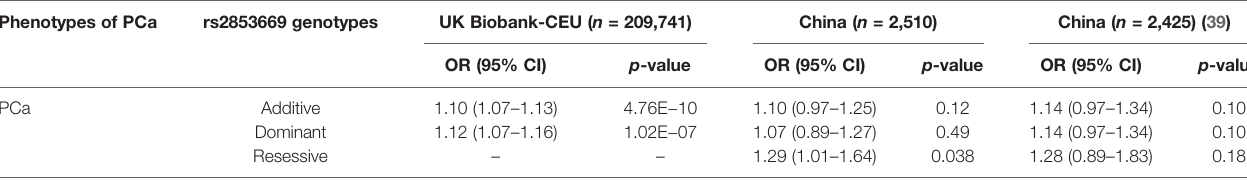
TABLE 1 | The association between rs2853669 variants and PCa or disease